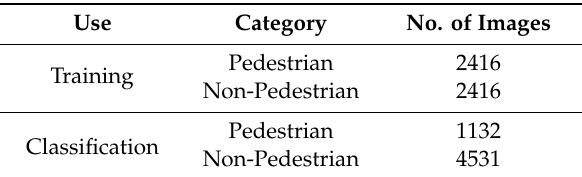
Table 1. Dataset for